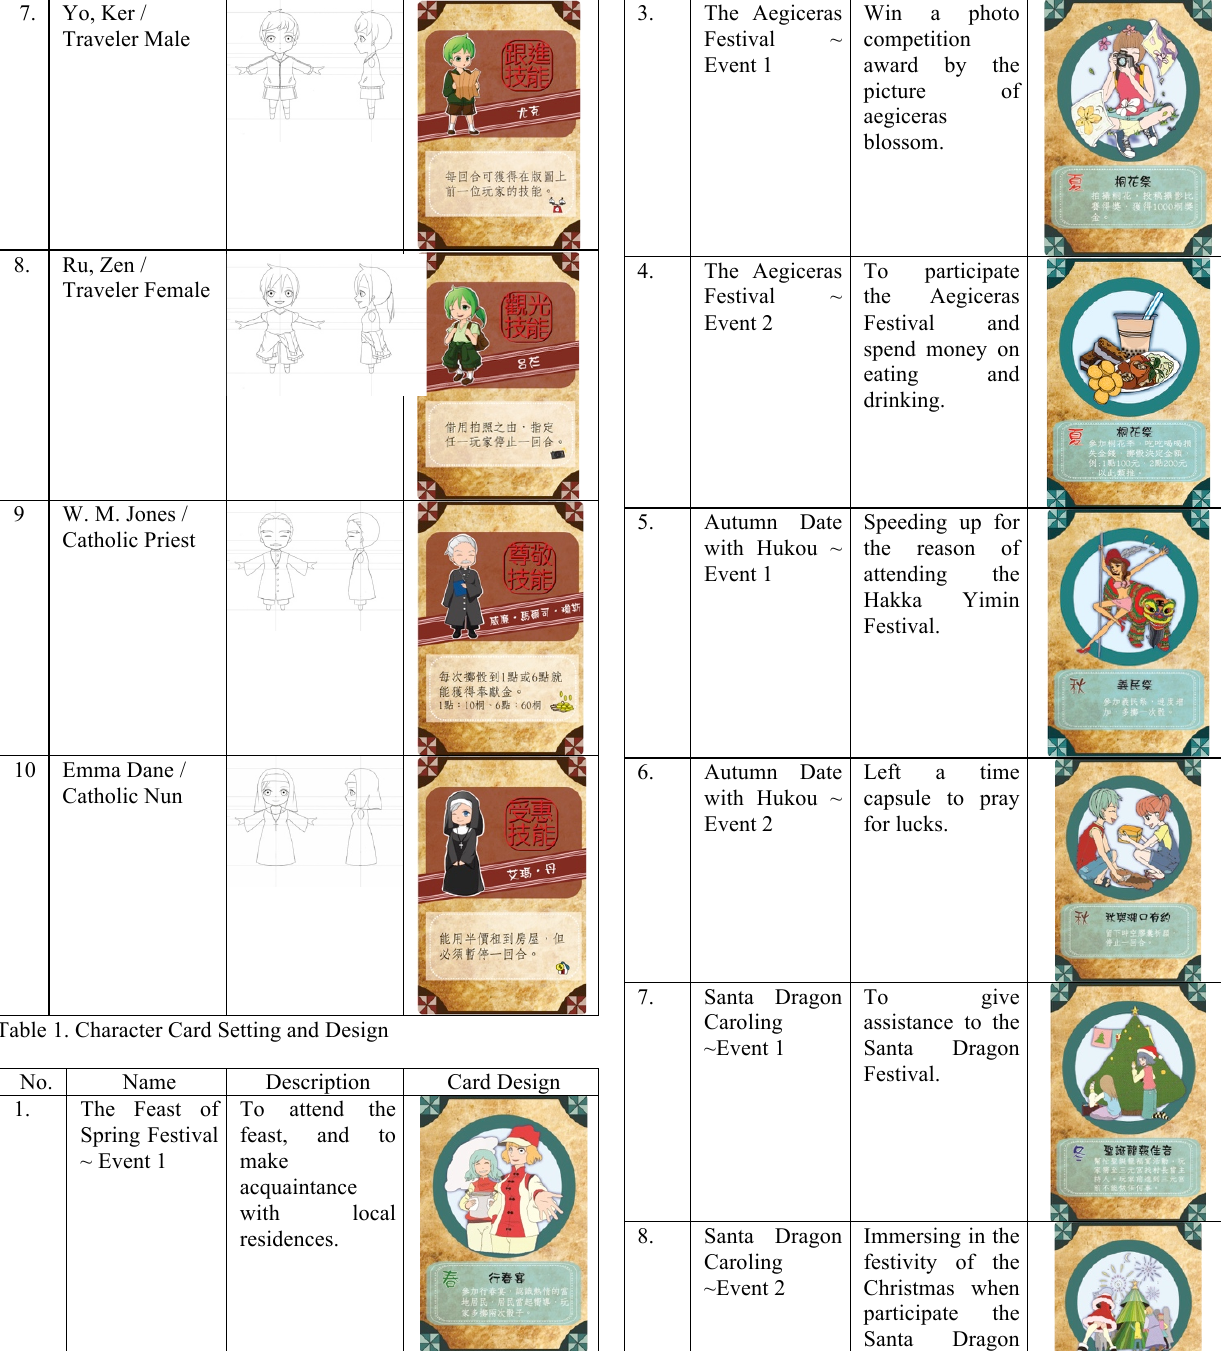
Table 2. Four Seasons Event Card Setting There are also several sets of Property Card, Chance Card, Fate Card, and Trap Card serve as board game items for players (playing visitor roles of the past Hukou Old Street) to collect, invest. Take the Property Card for example, there are 42 cards in total represent the real estates is located in the Hukou Old Street, and serve as 3D Building Card (front side) and Information Card (rear side) for AR Application to emerge realistic 3D buildings and Hukou old building information when the card is scanned by